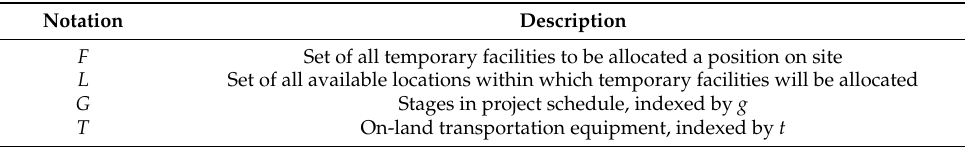
Table A1. Set notation employed in the MIP model.